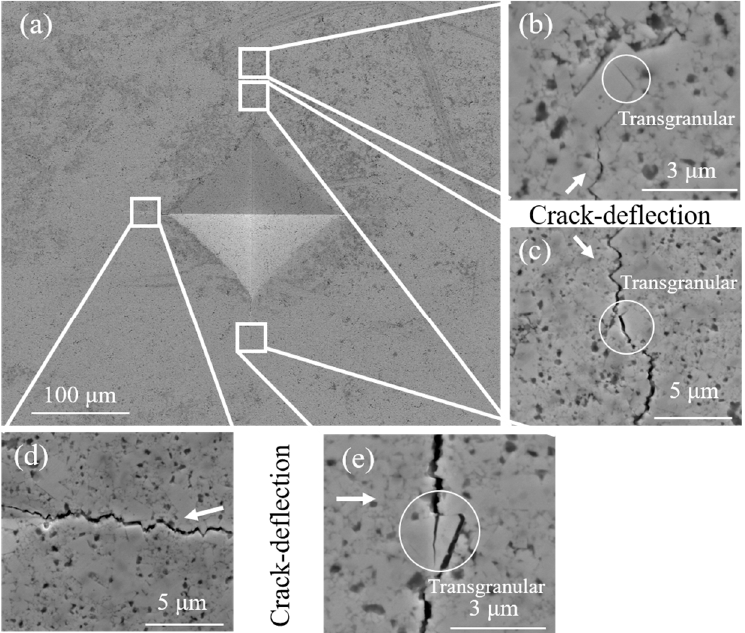
Figure 11. SEM images of indentation cracks observed in the sintered WC-10Ni 3 Al composites using C 6 H 12 . ( a ) Vickers indentation; ( b – e ) crack-deflection with transgranular.